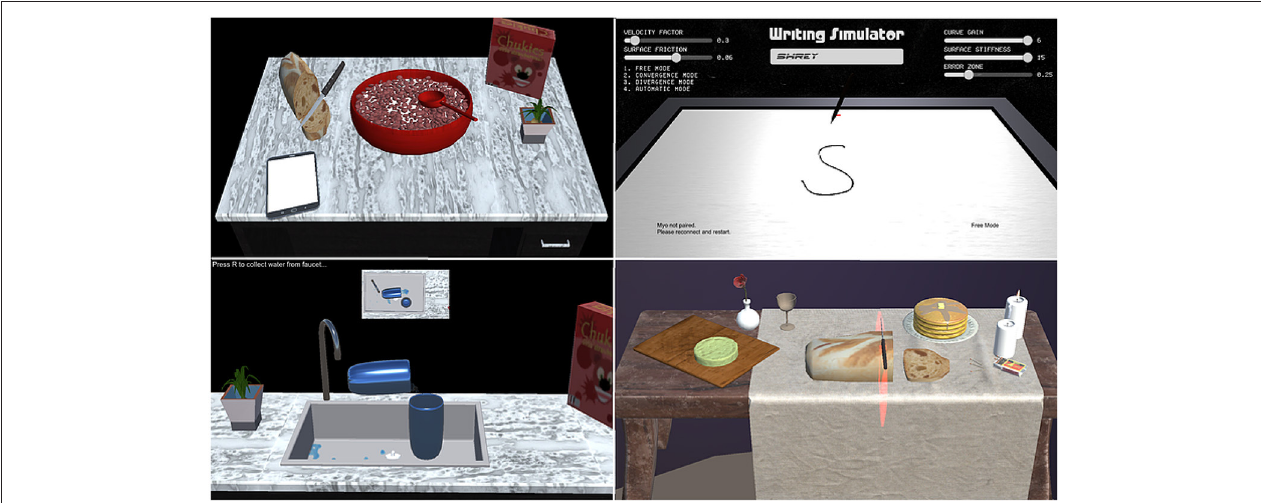
FIGURE 2 | Different virtual reality (VR) games that can emulate Activities of Daily Living (ADL), such as using a spoon (eating), pen (writing), knife (cutting), and glass (pouring) in clockwise order from top-left.